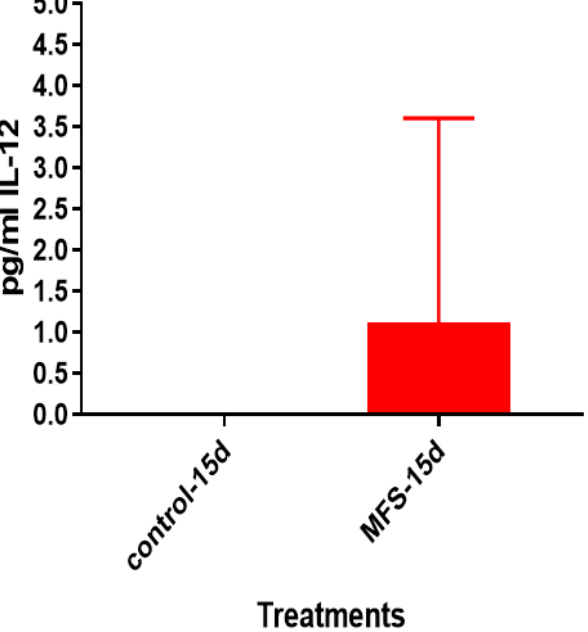
Figure 9. Assay of IL-12 in the supernatants from untreated and MFS-treated granulomas from healthy subjects. Assay of IL-12 was performed using an ELISA Ready-Set-Go kit from eBioscience. Data represent means ±SE from eight healthy individuals. Molecules 2018 , 23 , x FOR PEER REVIEW